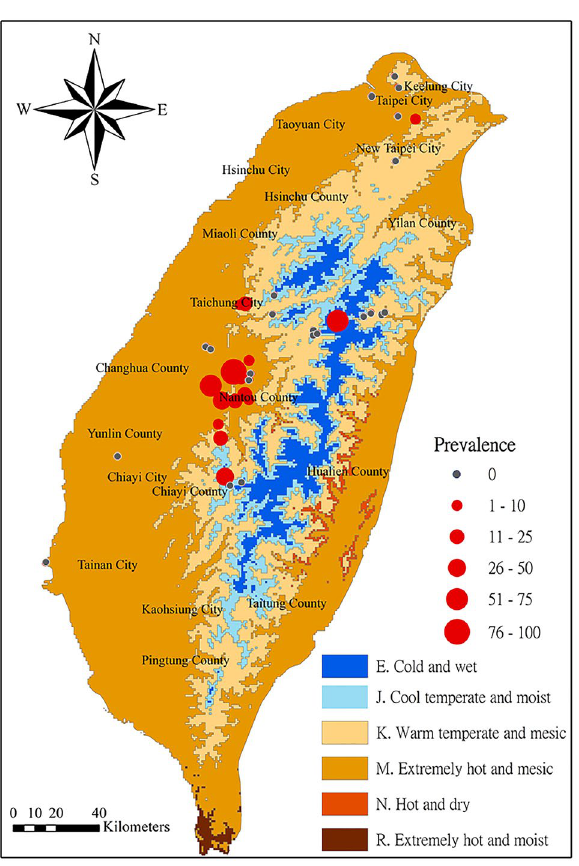
Figure 6. Distribution of Bd in the different bioclimatic zones of Taiwan 55 . The circle size corresponds to the prevalence